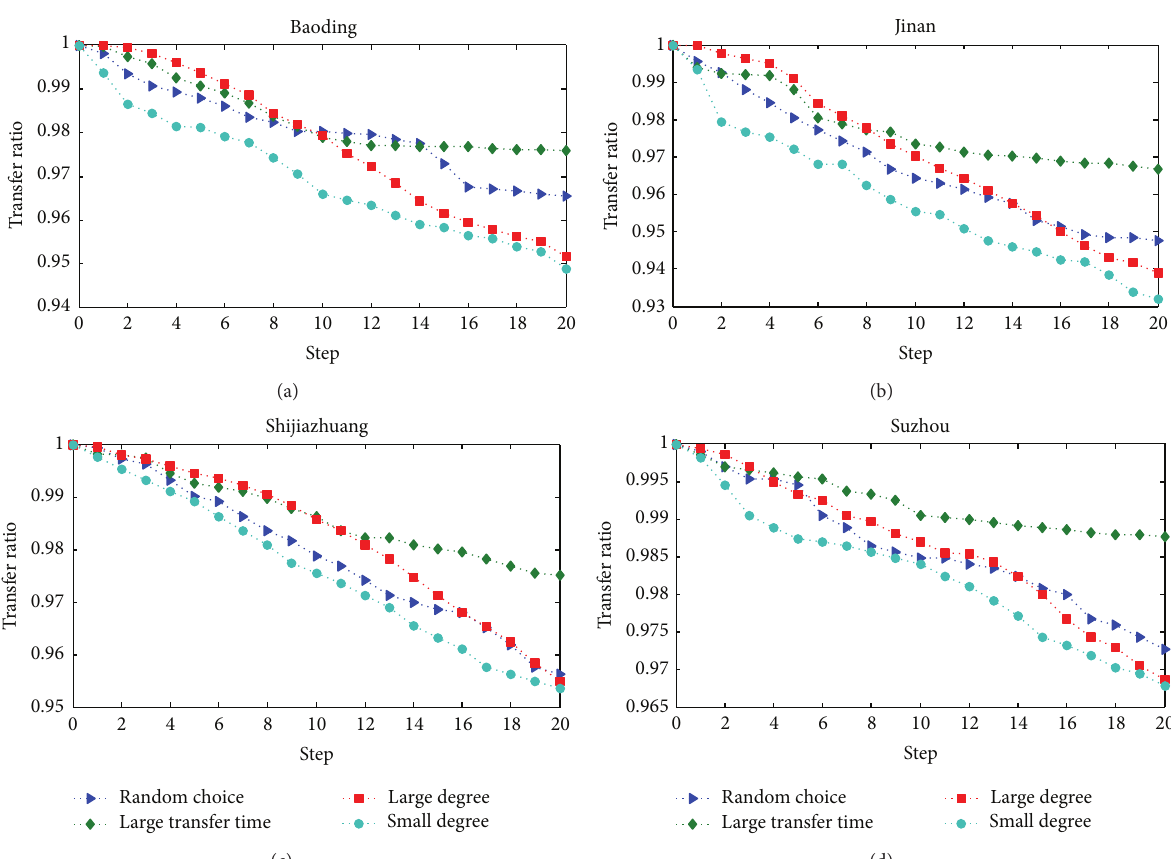
Figure 5: The transfer ratio with four adding edges modes: random choice, large transfer time, large degree, and small